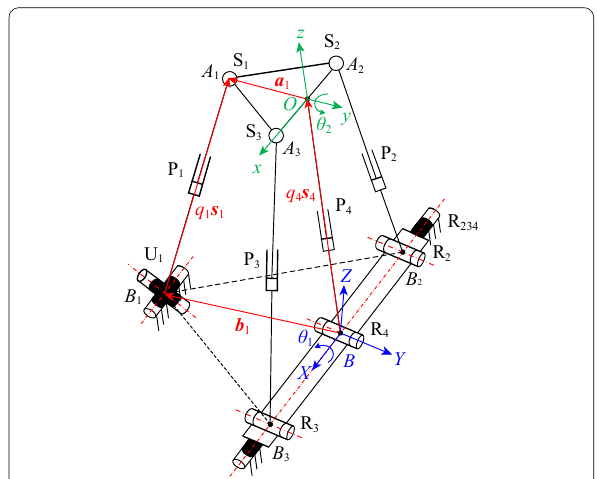
Figure 8 Schematic diagram of R(2RPS&RP)&UPS